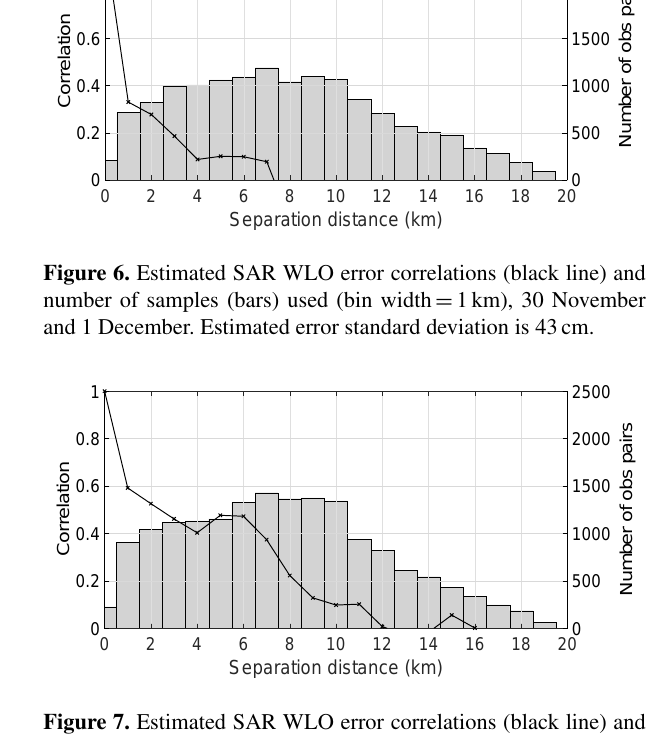
Figure 7. Estimated SAR WLO error correlations (black line) and number of samples (bars) used (bin width = 1km), 2 and 4 Decem- ber. Estimated error standard deviation is